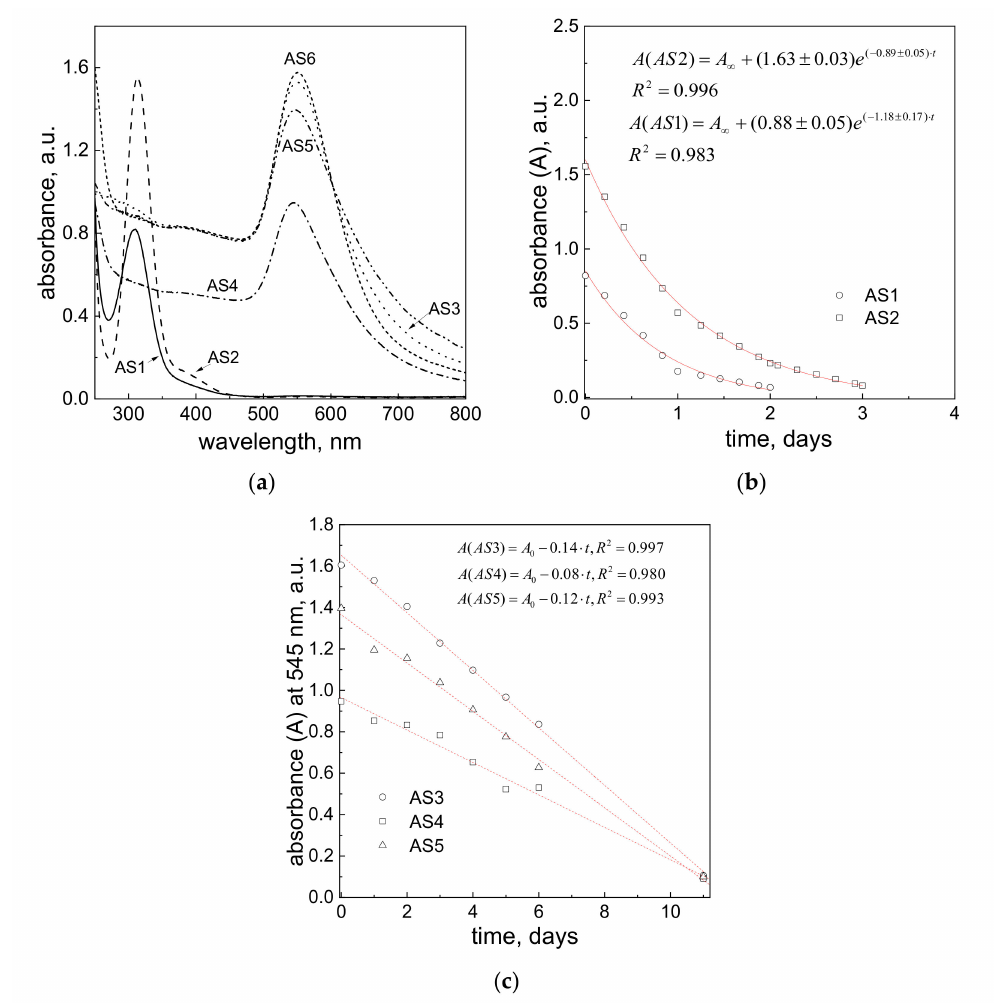
Figure 4. UV-Vis spectra of solutions: AS1–AS6 ( a ); Kinetic curves for process of adsorption of Au(III) ions at different media (samples AS1 and AS2) on activated carbon fibers carried out in the batch reactor ( b ); Kinetic curves for process of colloidal gold adsorption on activated carbon fibers carried out in the batch reactor (samples AS3–AS5) ( c ). Conditions: C 0, Au(III) = 0.3 mM, C 0, H2Asc = 0.6 mM, addition of PVA (sample AS4), amount of the activated carbon fibers 0.025 g/25 mL of the solution, T = 20 ◦